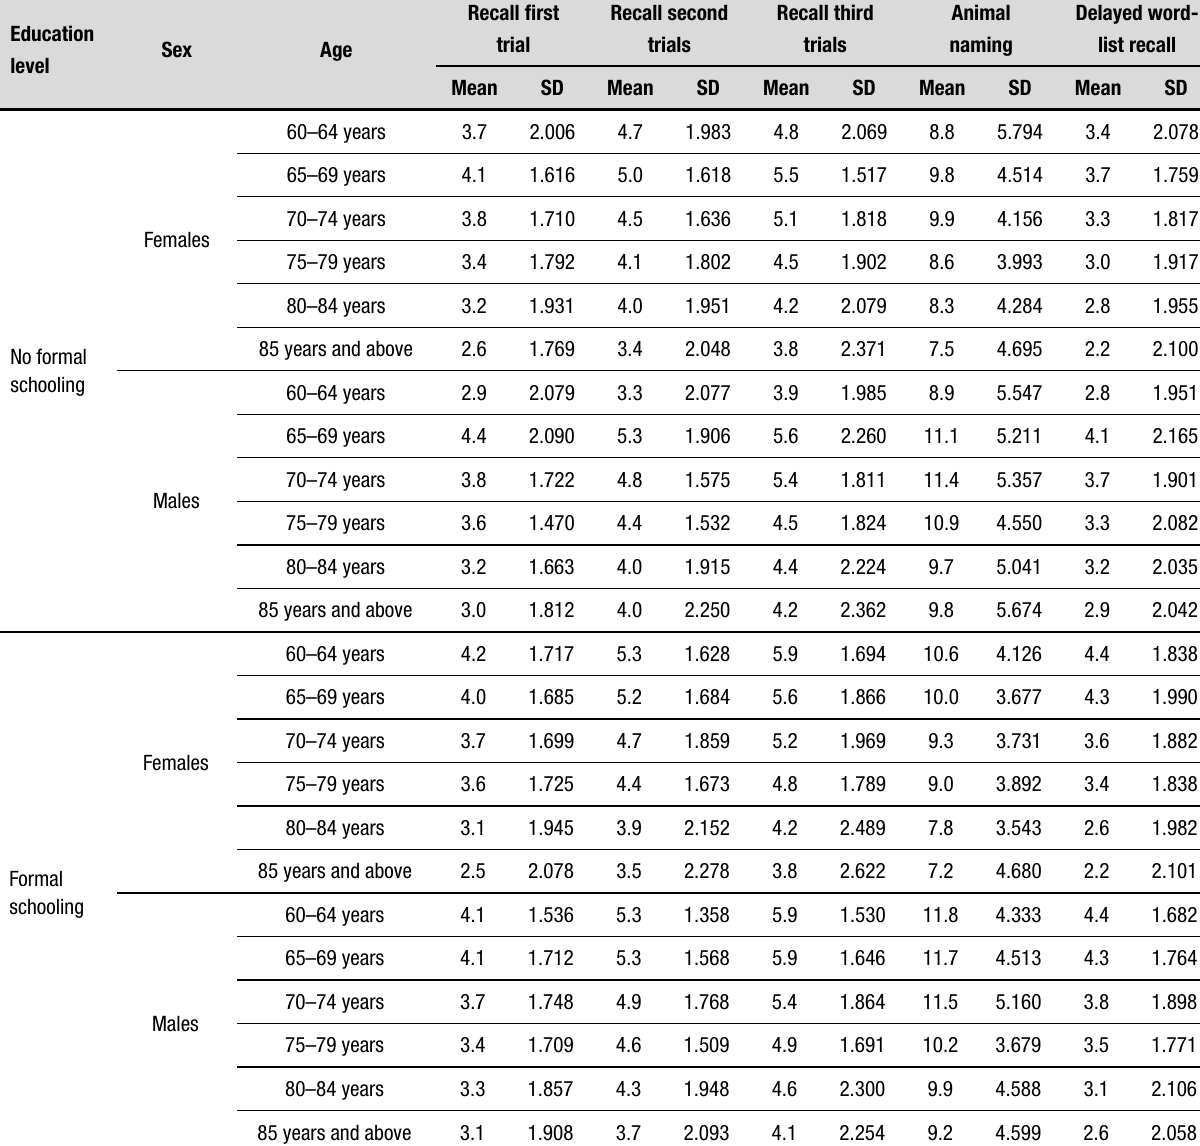
Table 4. Mean and standard deviation values for individual items of the Identification of Dementia in Elderly Africans cognitive screen by the categories of age, sex, and